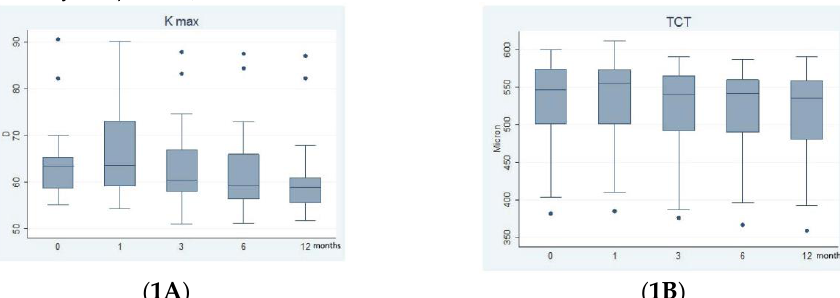
Figure 1. Effect of corneal cross-linking (CXL) on maximum keratometry (Kmax) and thinnest corneal